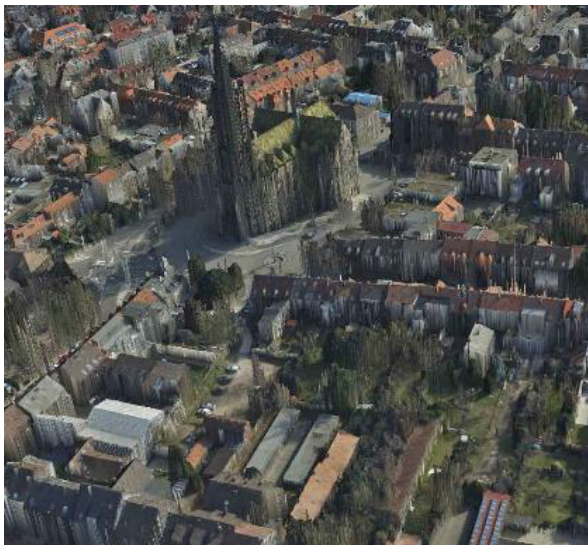
Figure 1. Colorized DSM of test area